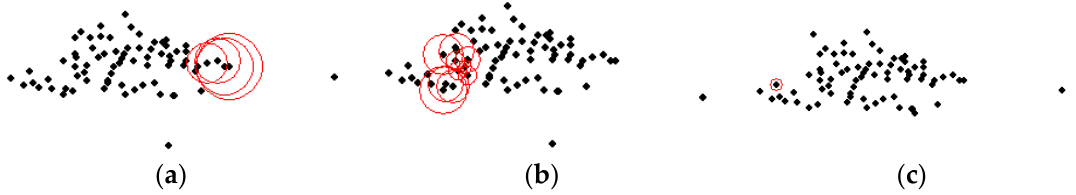
Figure 1. Clusters of cervical cancer. ( a ) Cervical cancer cut-off 75 cases; ( b ) endometrial cancer cut-off 350 cases; ( c ) ovarian cancer cut-off 6 cases.